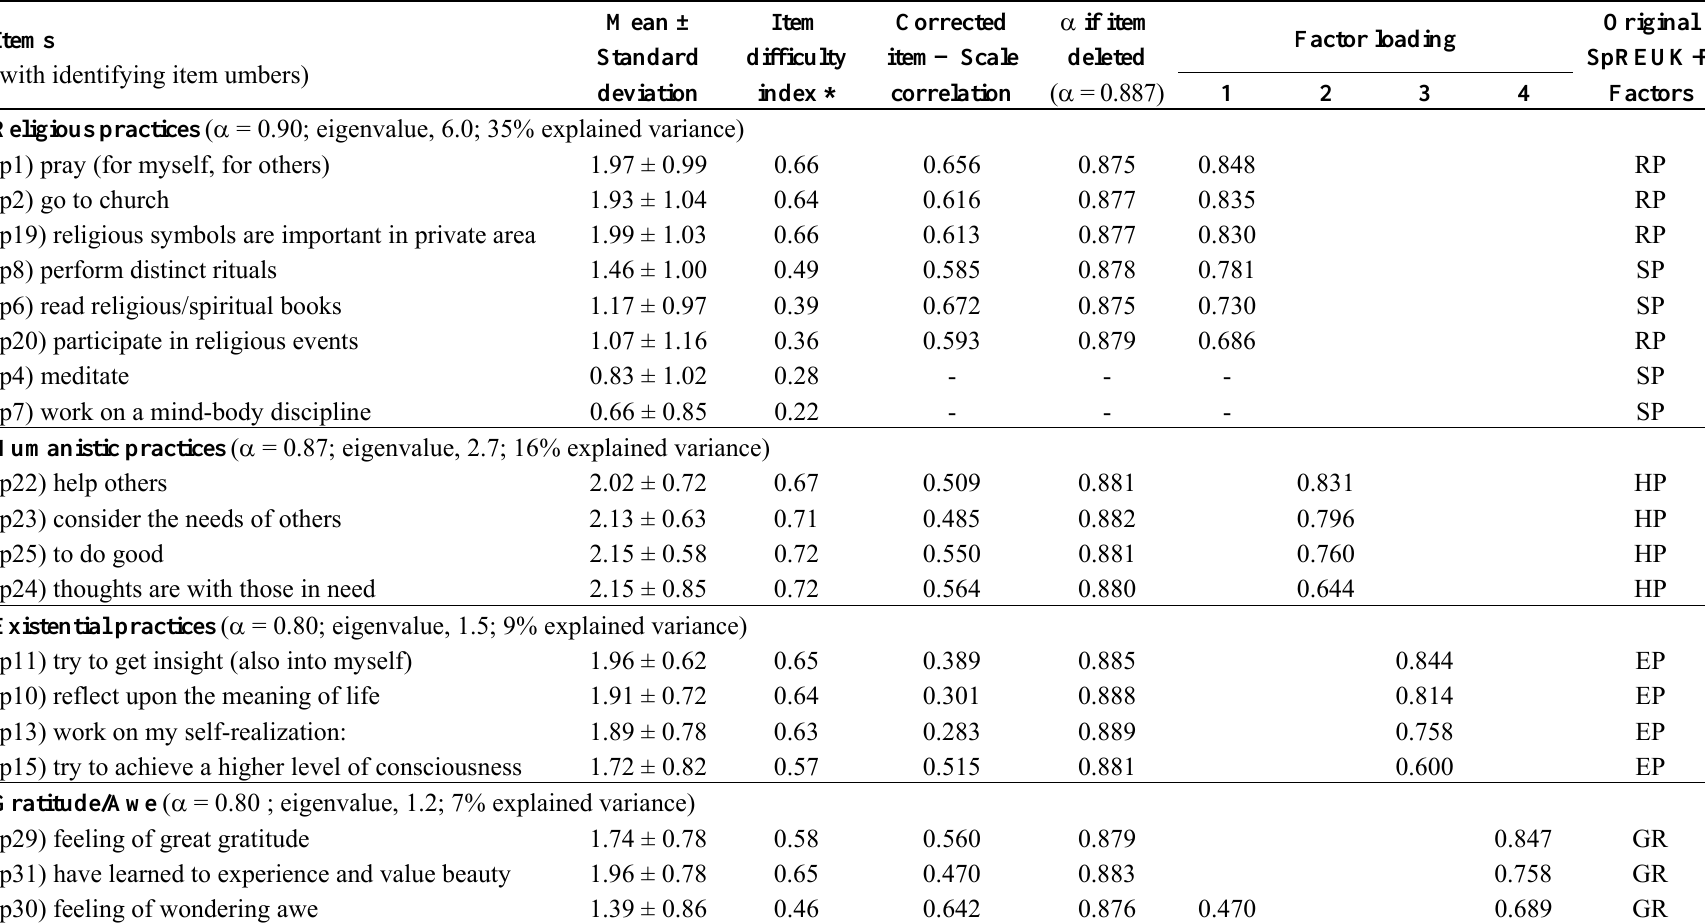
Table 2. Factorial structure of the SpREUK-P in its Polish version and the mean values of respective items.